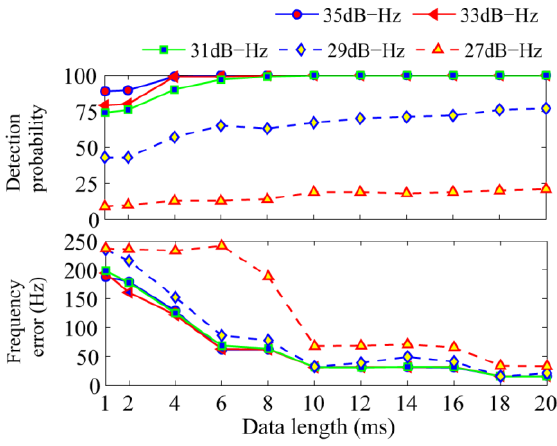
Figure 8. Influence of the FFT length on the proposed algorithm.